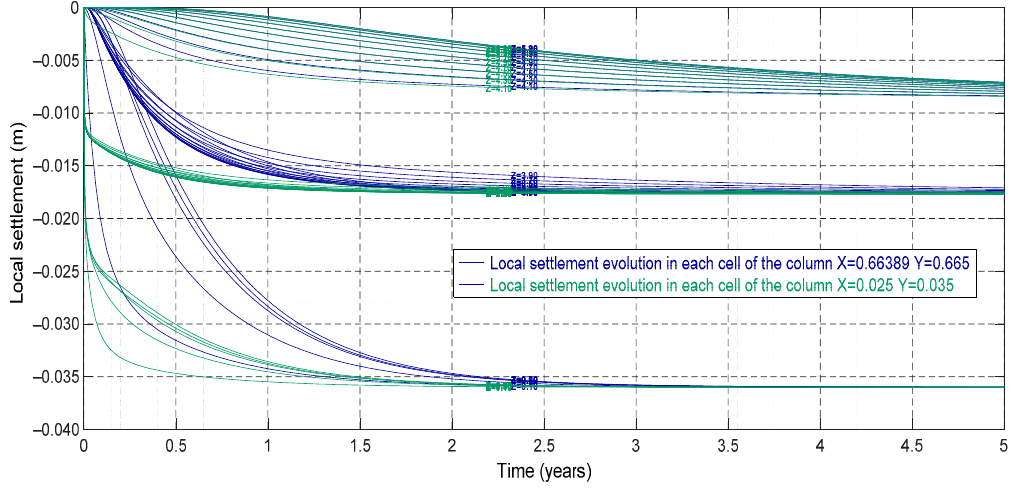
Figure 18. Local settlement evolution in each of the cells of two soil columns. (a = b = 0.7 m; c = 0.05 m; d = 4 m).